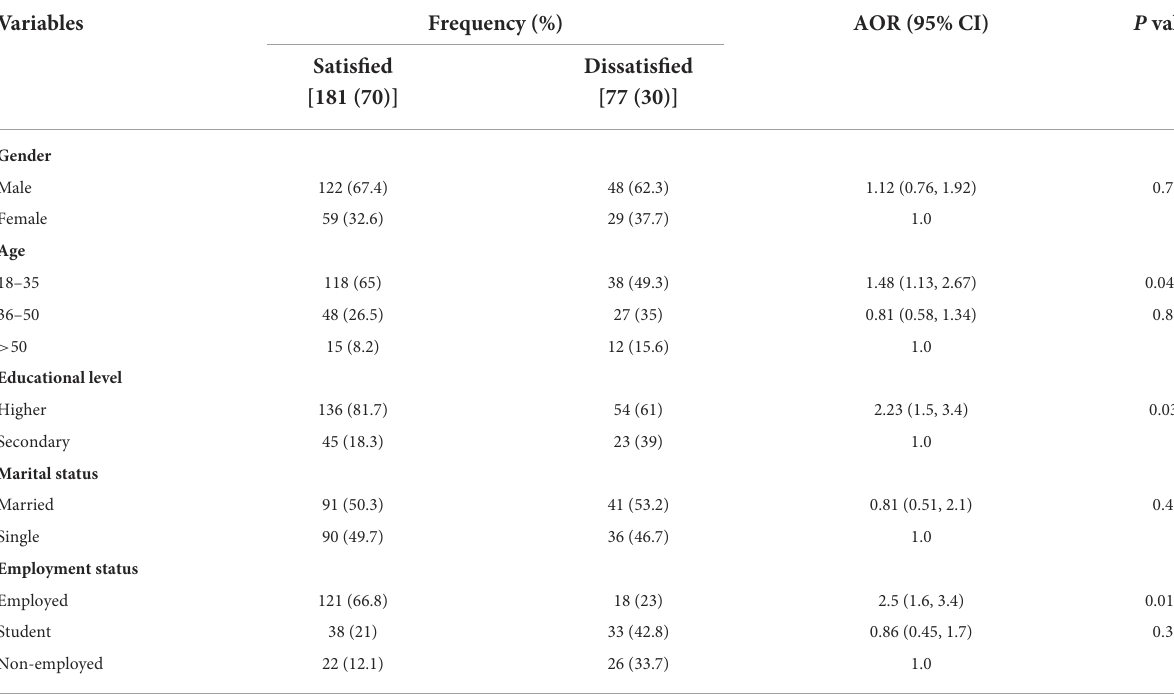
TABLE 3 Logistic regression analysis of factors influencing patients’ satisfaction on general healthcare services ( n =